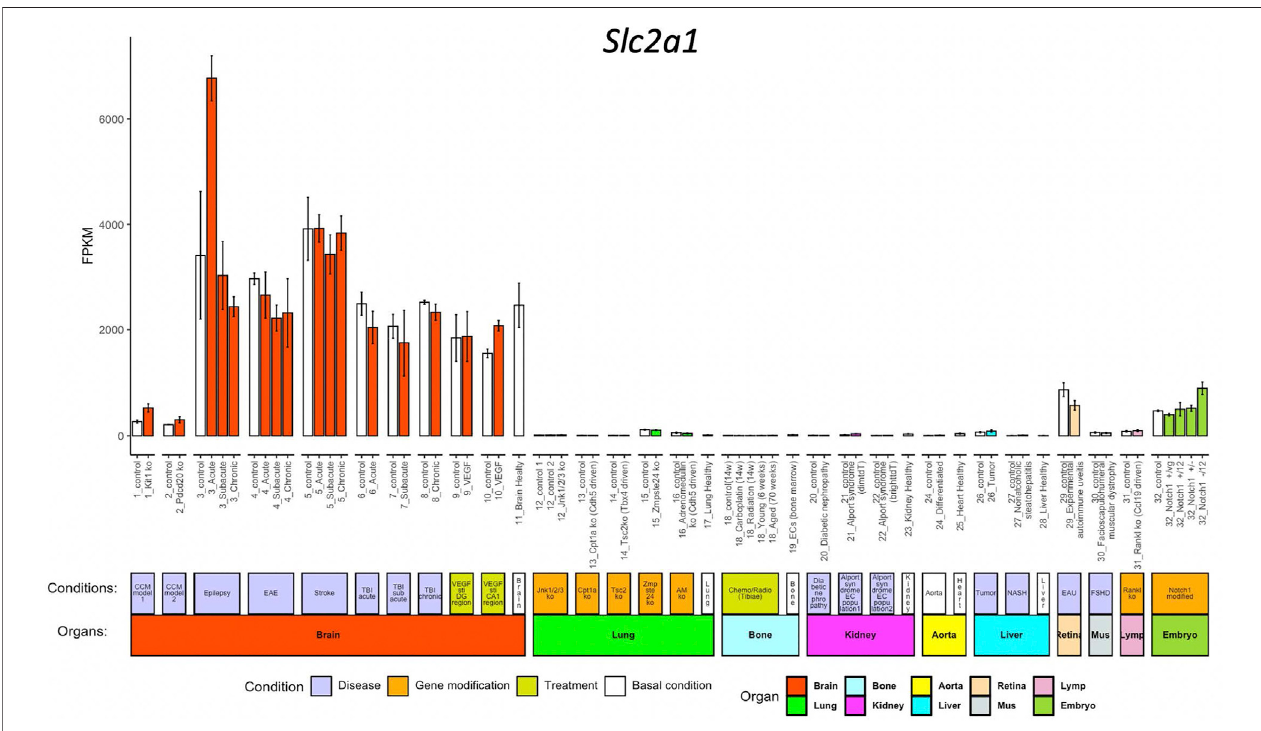
FIGURE2| Bar-plot of Slc2a1 expression indifferentconditions.The x -axisshowsthe71conditions,and the y -axisshowsthenormalized FPKMvalues. Eachbar shows the average expression (+/ − standard deviation) in each condition. The bars are colored according to their organ origins, and all basal/control conditions are shown with white color (high-resolution image is available in the ECO online